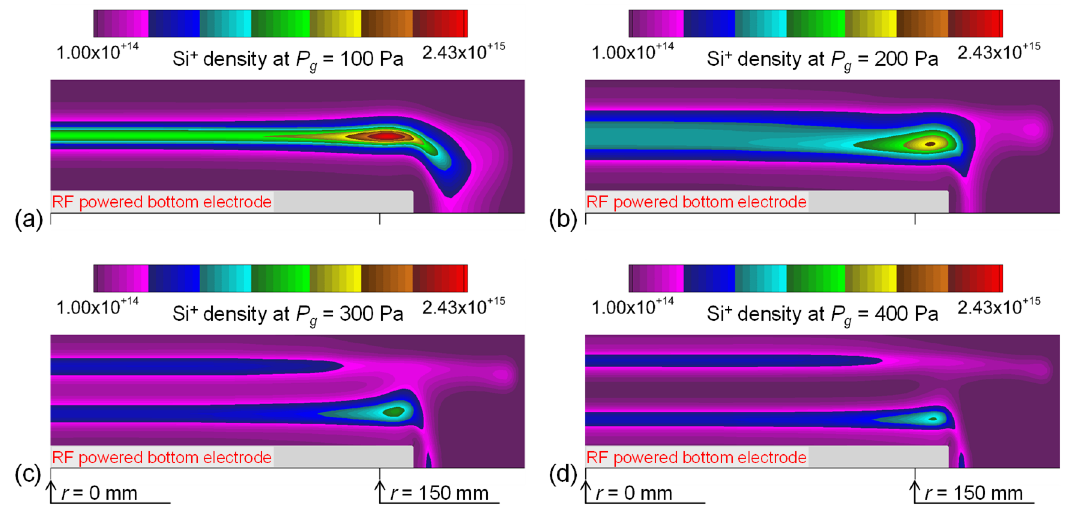
Figure 5. The spatial profiles of the time-averaged Si + density (m − 3 ) ( a ) for Case 5, ( b ) for Case 6, ( c ) for Case 7, and ( d ) for Case 8.